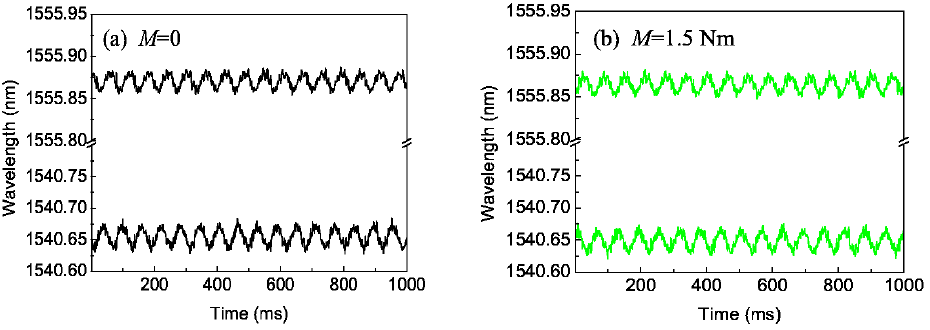
Figure 5. Central wavelengths of two FBGs with time: ( a ) M = 0; ( b ) M = 1.5 Nm.